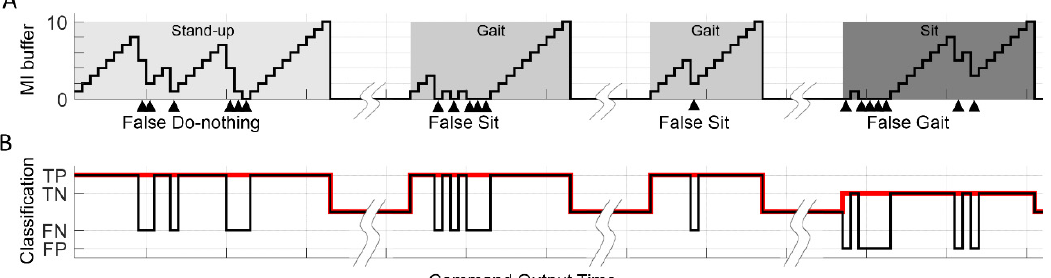
Figure 9. A representative example of the fill/empty log plot of MI buffers ( A ) and MI class discrimination plot ( B ) shares the timeline (subject no. 2). Three kinds of buffers (stand, gait, and sit, size of 10) were illustrated in light-gray, mid-gray, and dark-gray box. Stair shaped line depicts the fill/empty of each corresponding buffer. The false classification was marked as an arrow beneath the timeline. The deviation from true classification (solid red line) was shown in a square plot below.